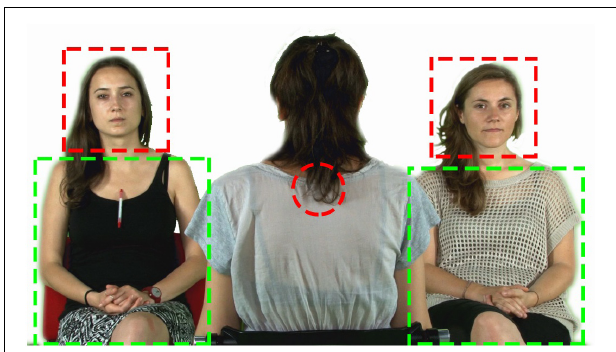
FIGURE 2 | Screenshot of one of the video frames with the superimposed AOIs (face, body, centre of the